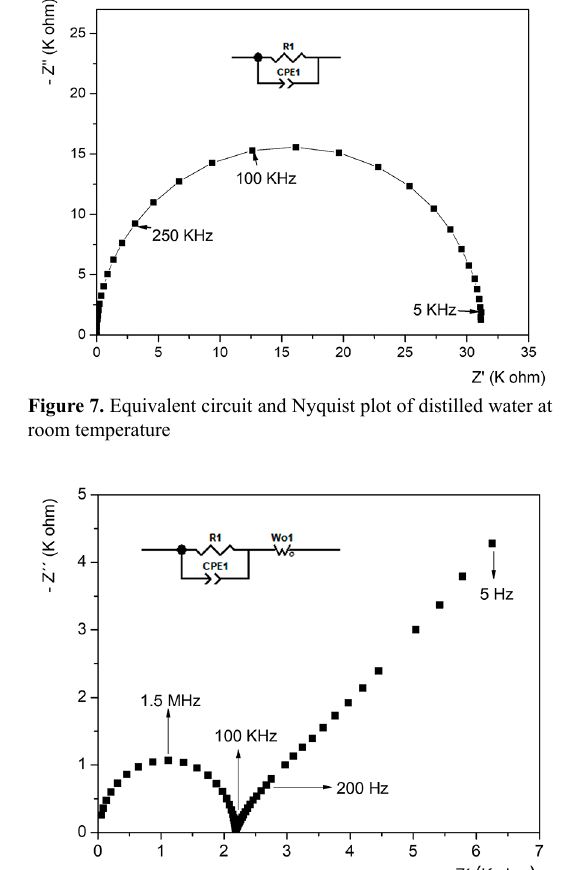
O powder suspension 2 4